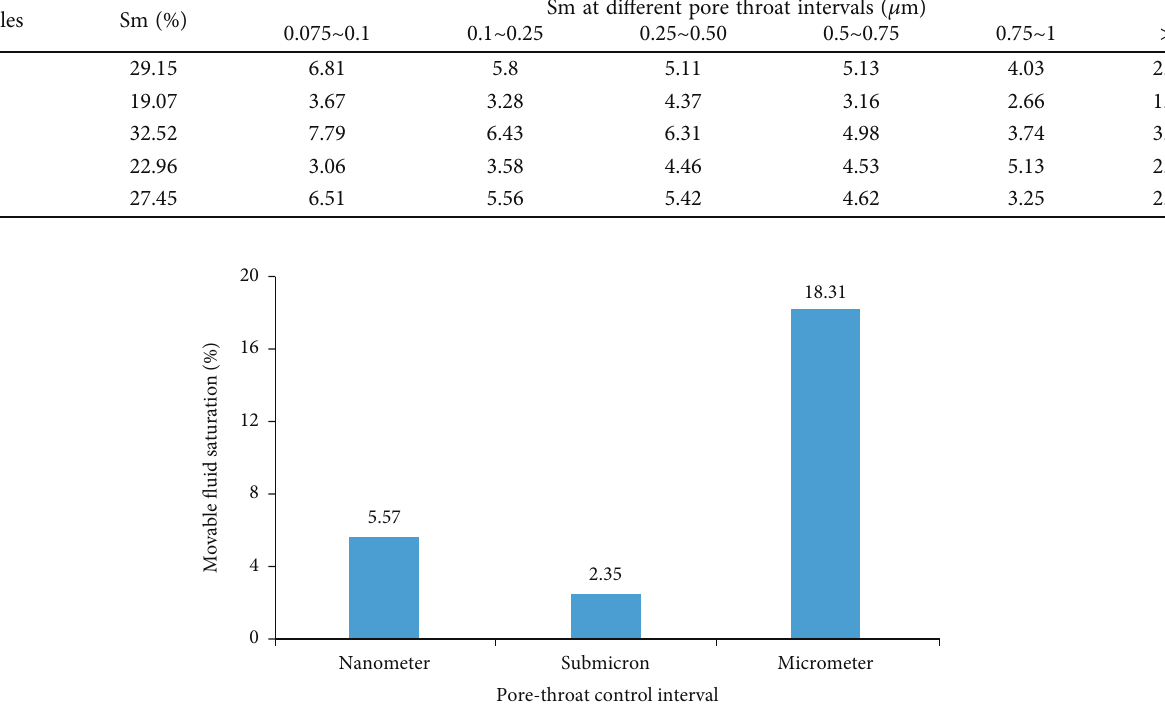
Figure 9: Average movable fl uid saturation of samples from the study area at di ff erent pore throat control